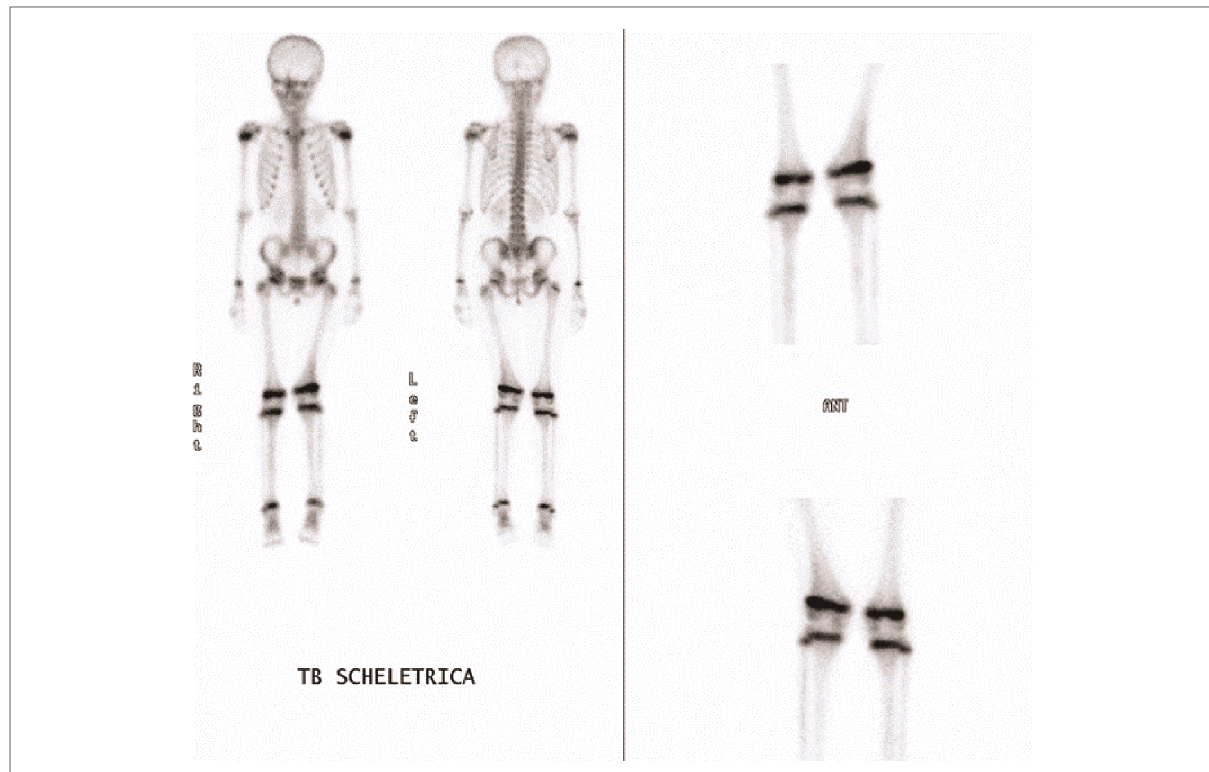
FIGURE 5 Bone scintigraphy highlighted an hypercaptation of the lateral portion of the left femoral